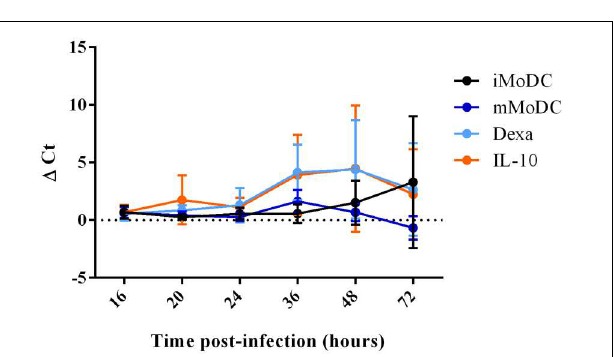
FIGURE 10 | PRRSV replication in MoDC supernatant between 16 and 72 h p.i. Immature/iMoDC (black), maturation cocktail treated mature mMoDC (dark blue), dexa treated MoDC (light blue) and IL-10 treated MoDC (orange) for 24 h before infection with PRRSV Lena using an m.o.i of 0.1. Viral RNA was extracted from cell supernatant at 16, 20, 24, 36, 48, or 72 h p.i, and TaqMan qPCR was used to obtain C t values. (cid:49) C t represents difference between C t at 2 h p.i (time zero) and C t at each time point p.i. Bars represent mean (cid:49) C t ±